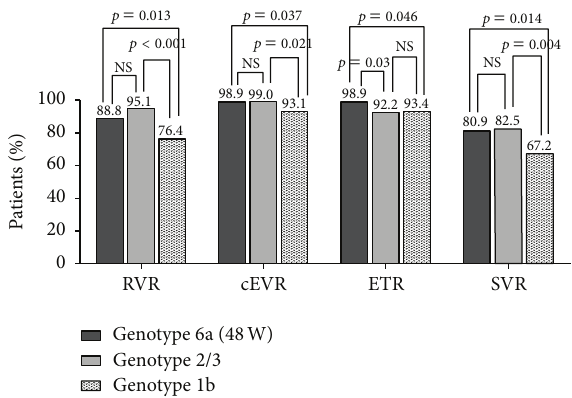
Figure 1: Comparison of the virological response rate to therapy with PEG-IFN plus ribavirin among patients with HCV-6a infection treated for 48 weeks, HCV-2/3, HCV-1b infection. RVR, rapid virologic response; cEVR, complete early virologic response; ETR, end-of-treatment response; SVR, sustained virologic